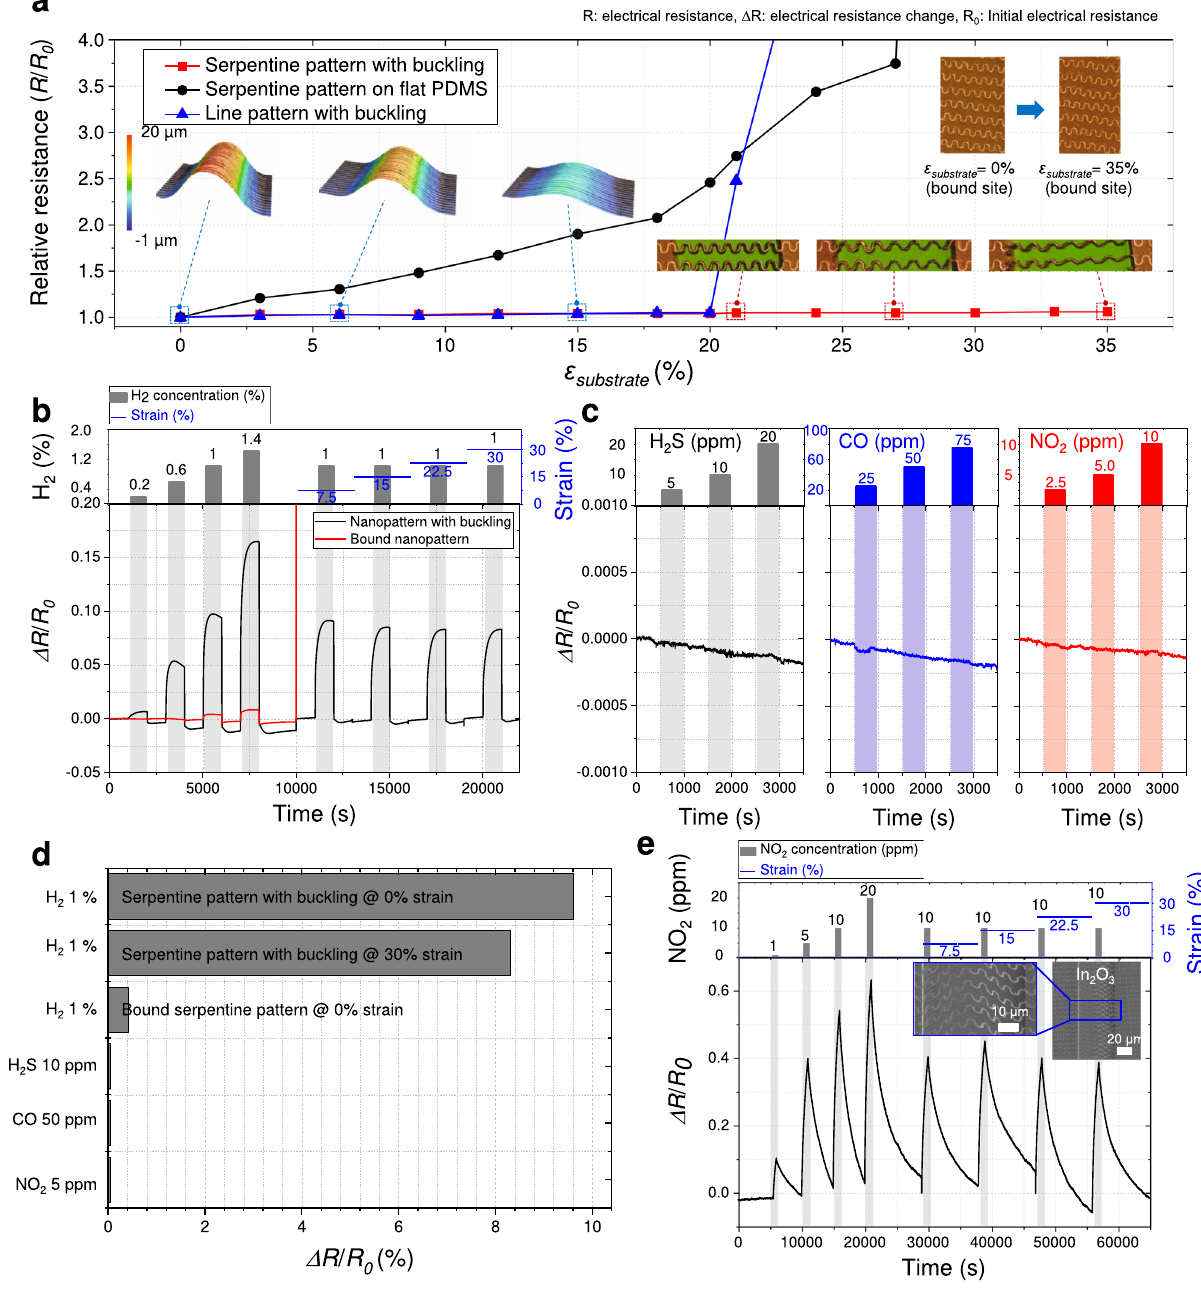
Fig. 5 | Electromechanical characteristics and performance of gas sensors. a Relative electrical resistance of Pd nanostructures with/without buckling as a function of external strain. b Relative resistance of a Pd nano-serpentine pattern with buckling and that of a bound Pd nanopattern as functions of H 2 level and external strain. c Relative resistance of the Pd nano-serpentine pattern with